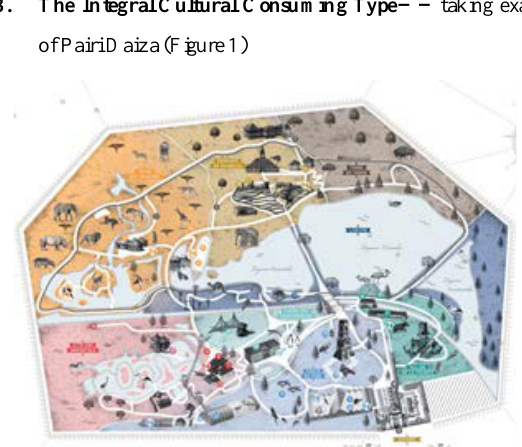
Figure 1.the site plan of Pairi Daiza (Image source: http://www.pairidaiza.eu/en)